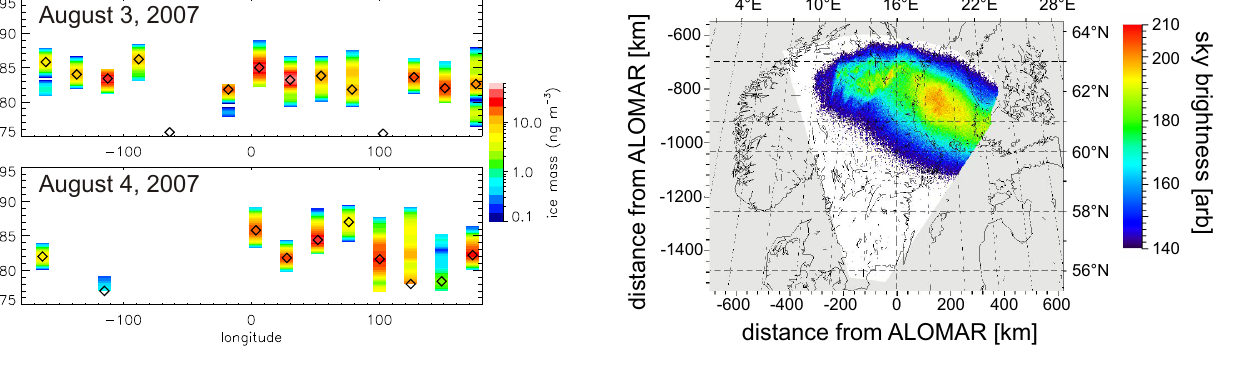
01:35UT in arbitrary units. The brightness was mapped assuming